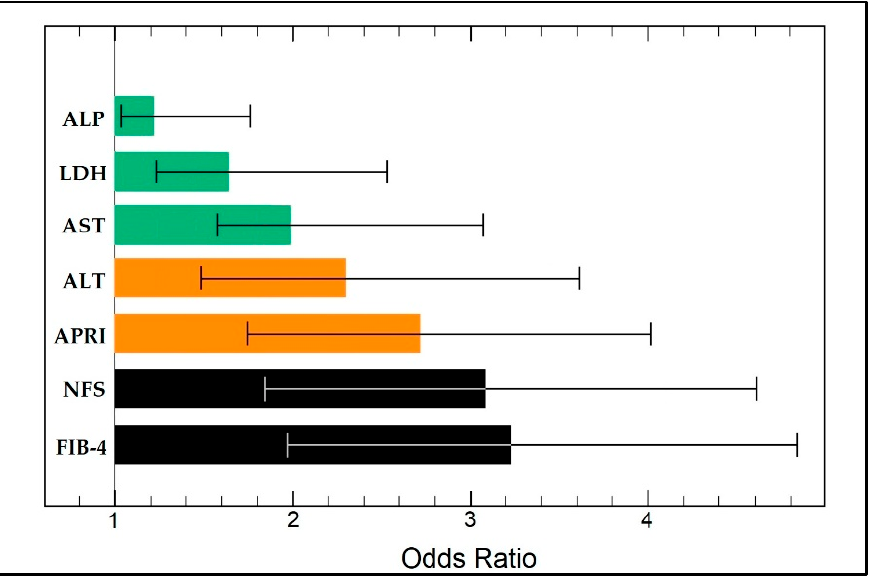
Figure 4. Multivariate risk factor analysis for mortality in the elderly ( ≥ 65 years old) admitted for SARS-CoV-2